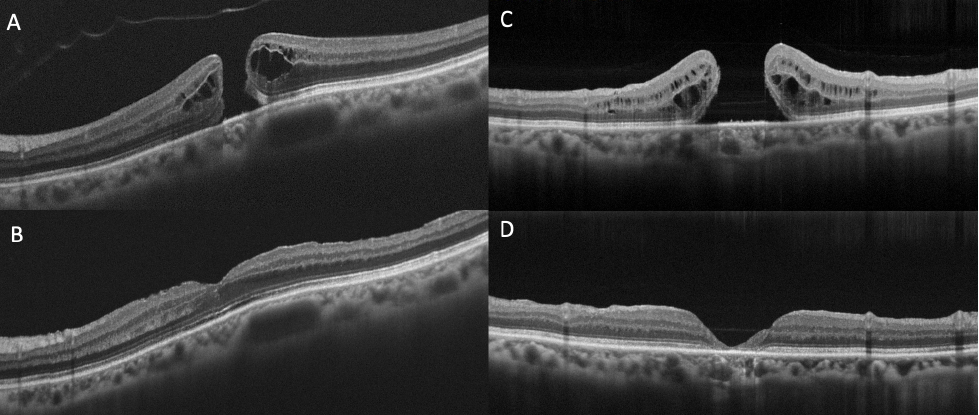
Figure 2. Optical Coherence Tomography (OCT) scans of full-thickness macular holes and defects in external limiting membrane (ELM), ellipsoid zone (EZ), and interdigitation zone (IZ) at baseline ( A , C ) and at six months follow-up ( B , D ). ( A ) Preoperative ELM, EZ and IZ are almost preserved and at postoperative follow-up ( B ) a quite full subfoveal restoration of the three bands can be appreciated. ( C ) Preoperative ELM, EZ and IZ defects are extensive and at postoperative follow-up ( D ) subfoveal atrophy development can be observed.